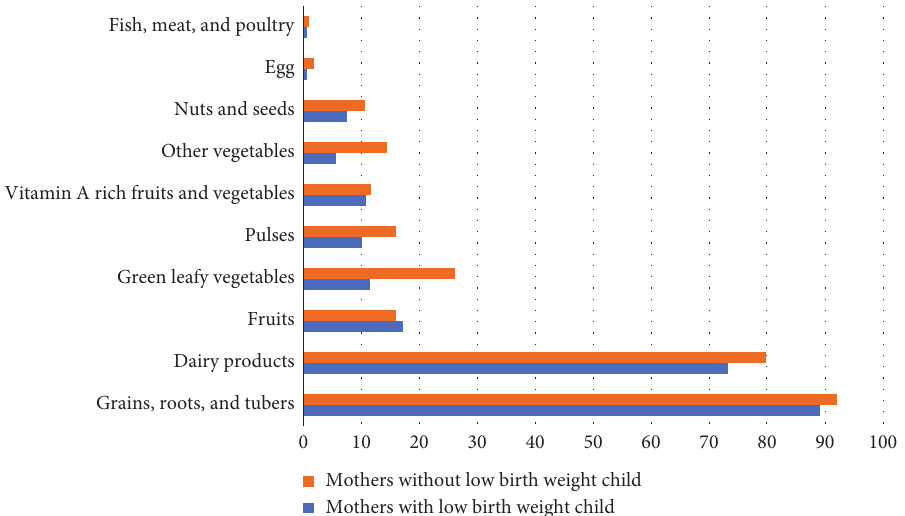
Figure 1: Distribution of the consumption rate of ten food groups between mothers with and without low birth weight child on a daily basis. Table 2: Logistic regression analysis showing stepwise regression for low birth weight with respect to selected background characteristics in Madhya Pradesh,